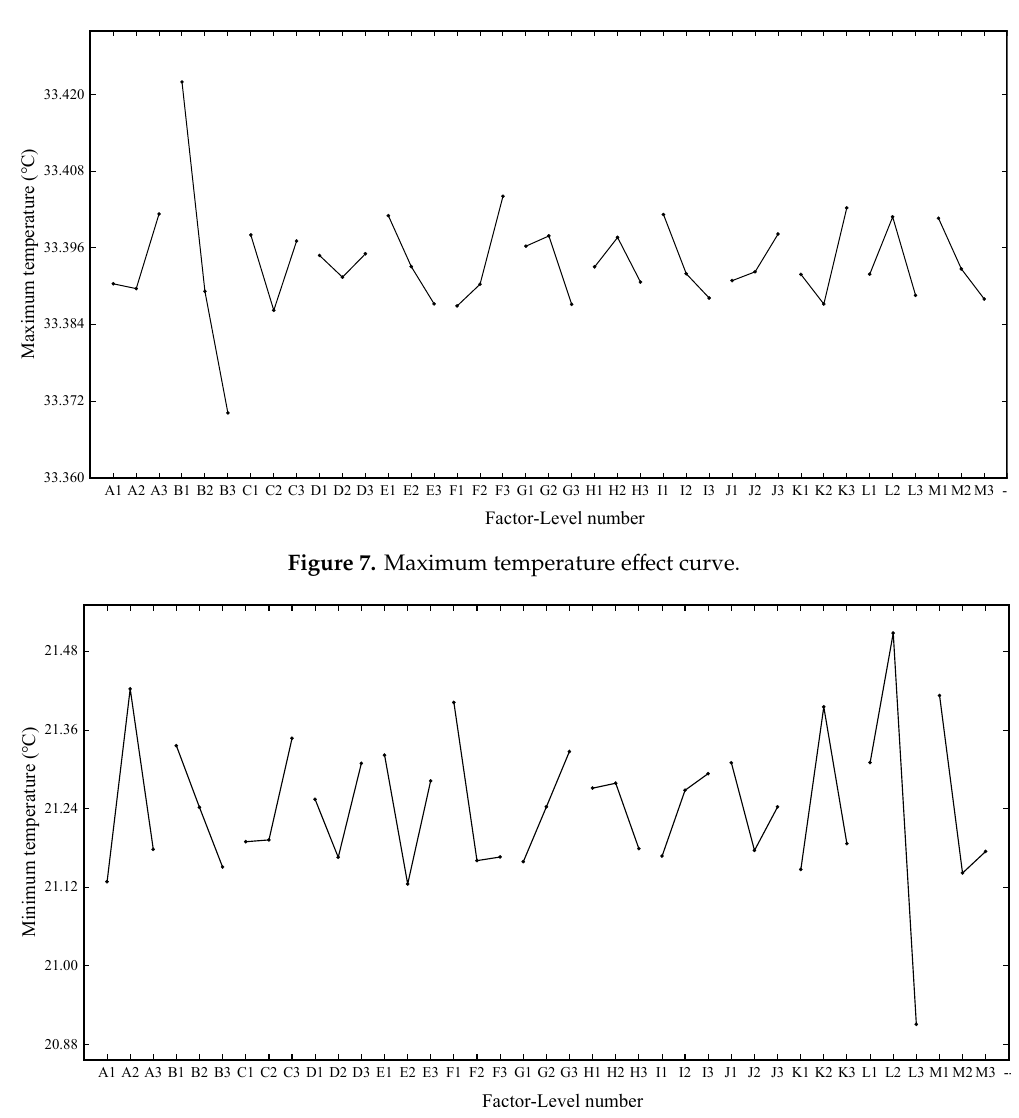
Figure 8. Minimum temperature effect curve.